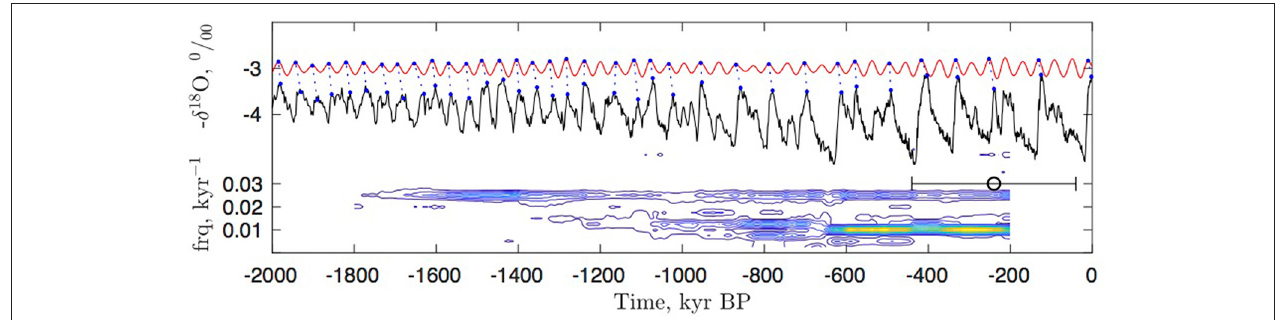
FIGURE 4 | The global stacked sediment isotope record from benthic foraminifera (black) along with the 65N insolation curve (red, arbitrary units) from Figure 1 . The gray lines show how each interglacial warm maximum is related to the nearest maximum of the insolation curve. The isotope record is a proxy for global ice volume and thus temperature. Note that the scale is inverted, such that temperature increases along the y-axis. The ice-core record in Figure 1 corresponds to the very last glacial cycle. The ocean record does not resolve the fast stadial-interstadial oscillations. In order to quantify the visual association a spectral analysis is shown in the lower part. The contour plot shows the power spectrum of the record in a 400 kyr running window (indicated by the black bar). The center point of the window is on the x -axis, while the frequency is on the y -axis. The upper contour corresponds to approximately 1/40 kyr − 1 , present in the full record. The lower contour corresponds to approximately 1/100 kyr − 1 only being predominant after the